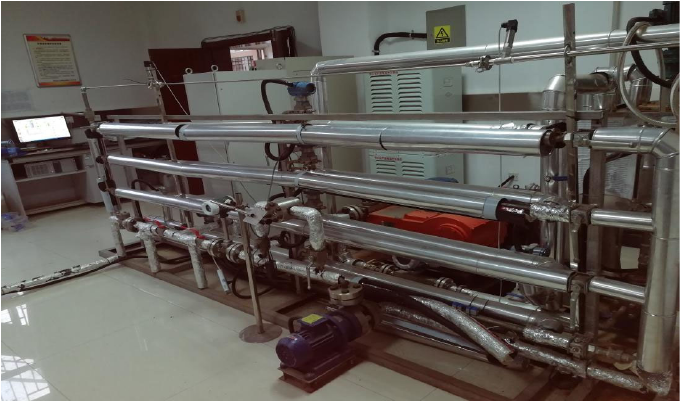
Figure 6. Fracturing fluid friction test apparatus.